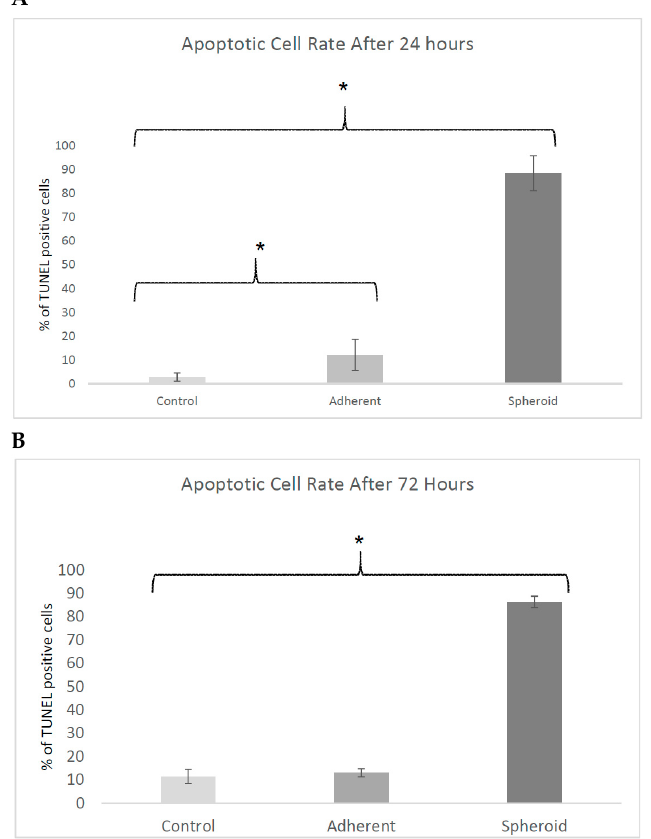
Figure 4. Terminal uracil-nicked end labeling (TUNEL) assays after 24 h ( A ) and after 72 h ( B ). The apoptosis rate was significantly increased in the adherent cells and in the spheroids after 24 h. After 72 h, the apoptosis rate was significantly increased in the spheroids compared to the 1-g control (* p <